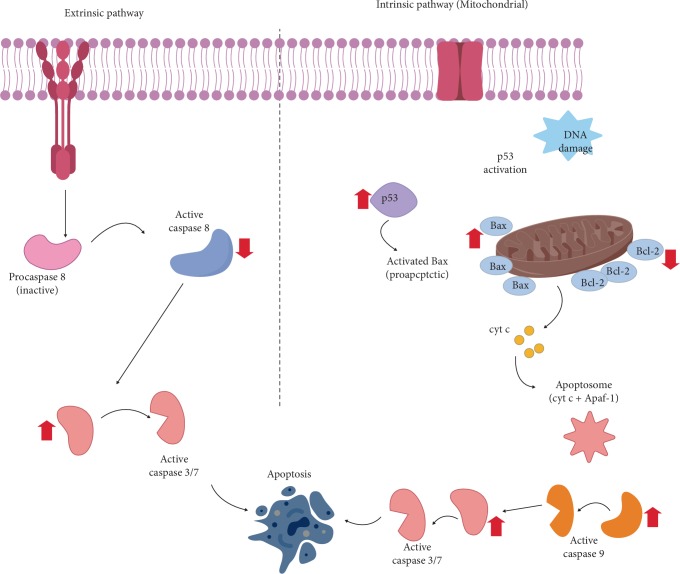
The proposed mechanism of apoptosis for the methanol extract of CA at 10 and 15 µg/ml concentrations.